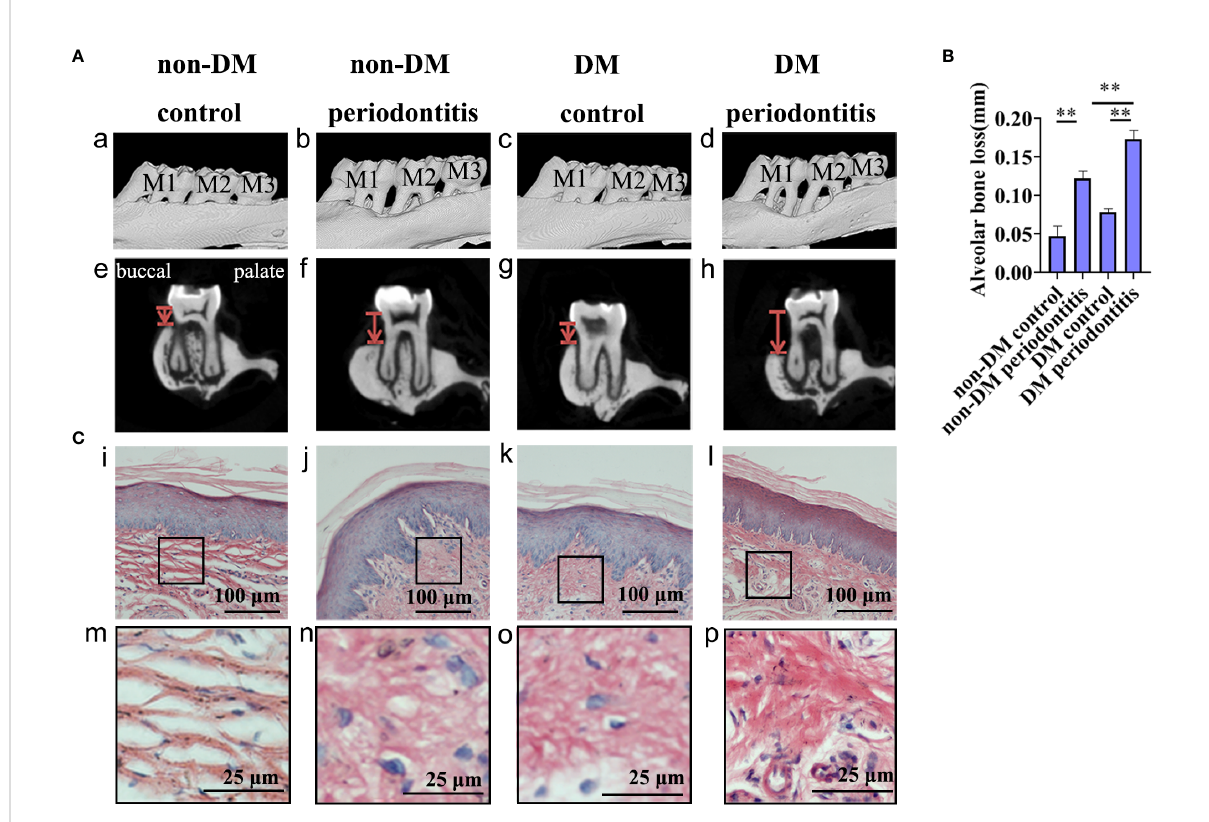
FIGURE 3 Diabetic rats with periodontitis showed more severe alveolar bone loss and intense gingival in fl ammatory response than non-diabetic rats. The fi gures present the micro-CT images and sections obtained individually from the non-DM control group, non-DM periodontitis group, DM control group and the DM periodontitis group. Non-DM control group, health control without type 2 diabetes mellitus (T2DM) and periodontitis; non-DM periodontitis group, ligation/ P. gingivalis- induced periodontitis but without T2DM; DM control group, high-fat diet and low dose of streptozotocin-induced T2DM but without periodontitis; DM periodontitis group, combination periodontitis and T2DM. (A) Micro-computed tomography images of the maxillary fi rst molars from (a-d). The distance between two red lines, cemento-enamel junction (CEJ) and the alveolar bone crest, represents the alveolar bone resorption (e-h). (B) Statistical analysis of the alveolar bone loss. Data are presented as mean ± SD (n=4) and are shown in the bar graphs, repeated 3 times (** P <0.01, compared with the control group or the non- DM group). (C) Hematoxylin and eosin staining of sections